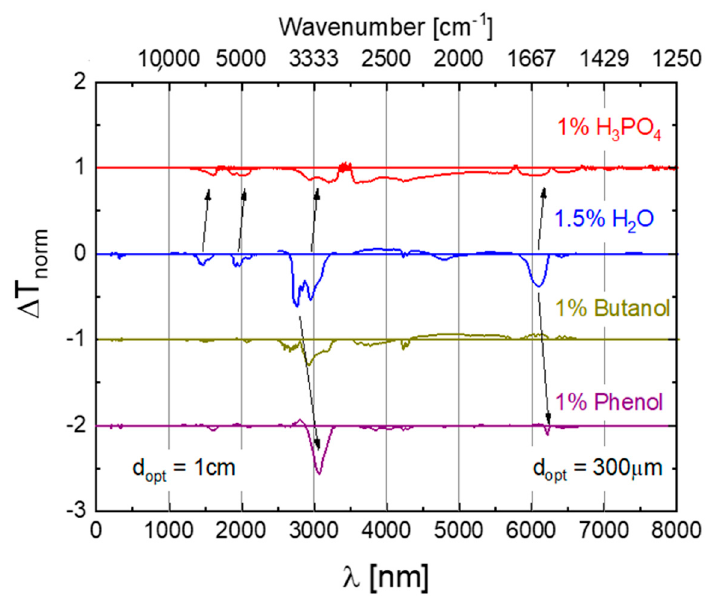
Figure A3. Difference spectra of phenol, butanol, and water contaminated SKYDROL LD4 as measured relative to a reference specimen containing 0.2% H 2 O. The top panel displays a spectrum of phosphoric acid that contains an amount of water that unavoidably comes with the H 3 PO 4 .